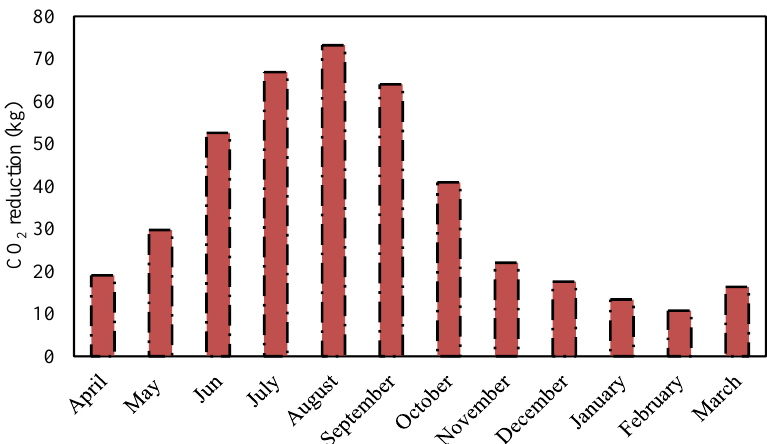
Fig. 16. Monthly CO2 reduction for PVT/(glazed)ST system at the mass flow rate of 50 kg/h on a typical day in 12